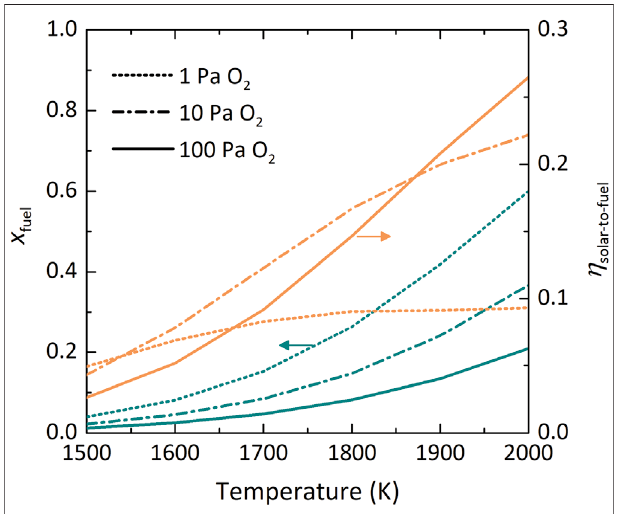
FIGURE 6 | Dual-membrane reactor performance indicators x fuel (teal) and η solar-to-fuel (orange) as a function of T at various p O